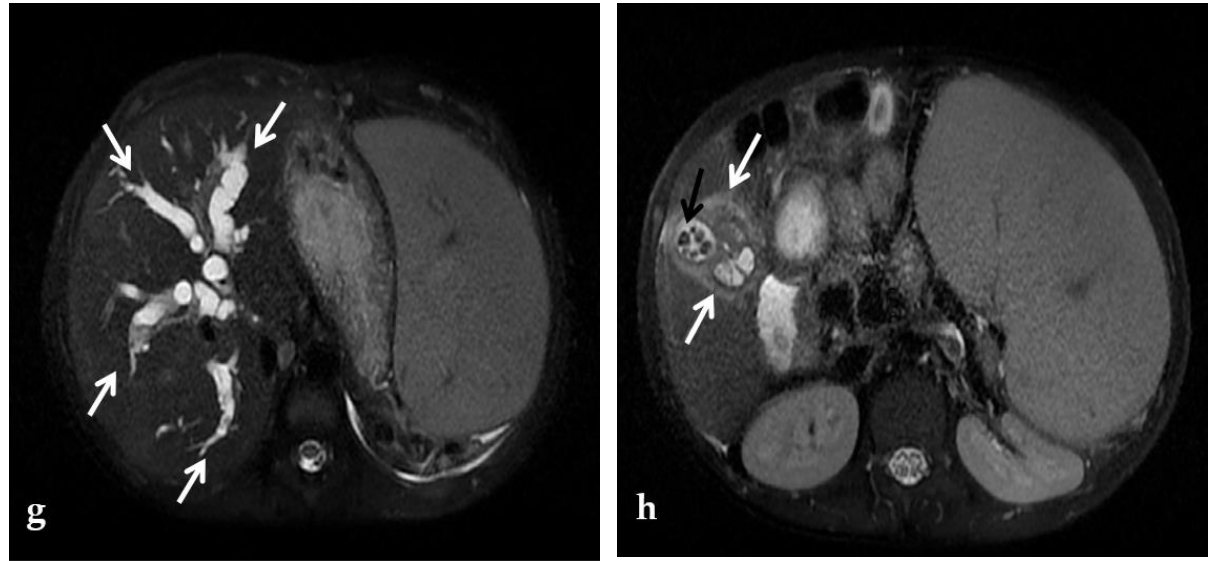
Figure 2. CDUS, CT, and MR images of a 9-year-old male with intrahepatic and extrahepatic cavernous transformation of the portal vein and portal biliopathy who presented with jaundice and cholangitis. ( a ) A Color-Doppler Ultrasound image shows multiple collateral vessels at the porta hepatis (arrows) and the absence of the main portal trunk. ( b ) Spectral evaluation of the major collateral vein of the cavernoma shows an hepatopetal flow with a velocity within normal ranges, which could potentially be misleading by an unexperienced operator. ( c ) An ultrasound image scan through the gallbladder shows a mildly echogenic endoluminal stone in the gallbladder (arrow). ( d ) Color-Doppler Ultrasound image shows multiple dilated collateral cavernous vessels in the gallbladder fossa (arrow). ( e ) Portal phase axial CT image shows dilation of intrahepatic biliary ducts (arrow) due to extrinsic compression of the common biliary duct by the cavernoma. ( f ) A caudal axial CT view in the portal venous phase shows a mildly hyperdense stone in the gallbladder (white arrow) which is surrounded by dilated cavernous vessels (black arrow). ( g ) Axial T2-weighted MR image shows intrahepatic biliary dilatation (arrows) due to common biliary duct extrinsic obstruction by prominent paracholedochal collateral cavernous vessels. ( h ) A caudal axial T2-weighted MR view shows wall thickening of the gallbladder (white arrows) which contains other multiple small gallstones in the fundus (black arrow).